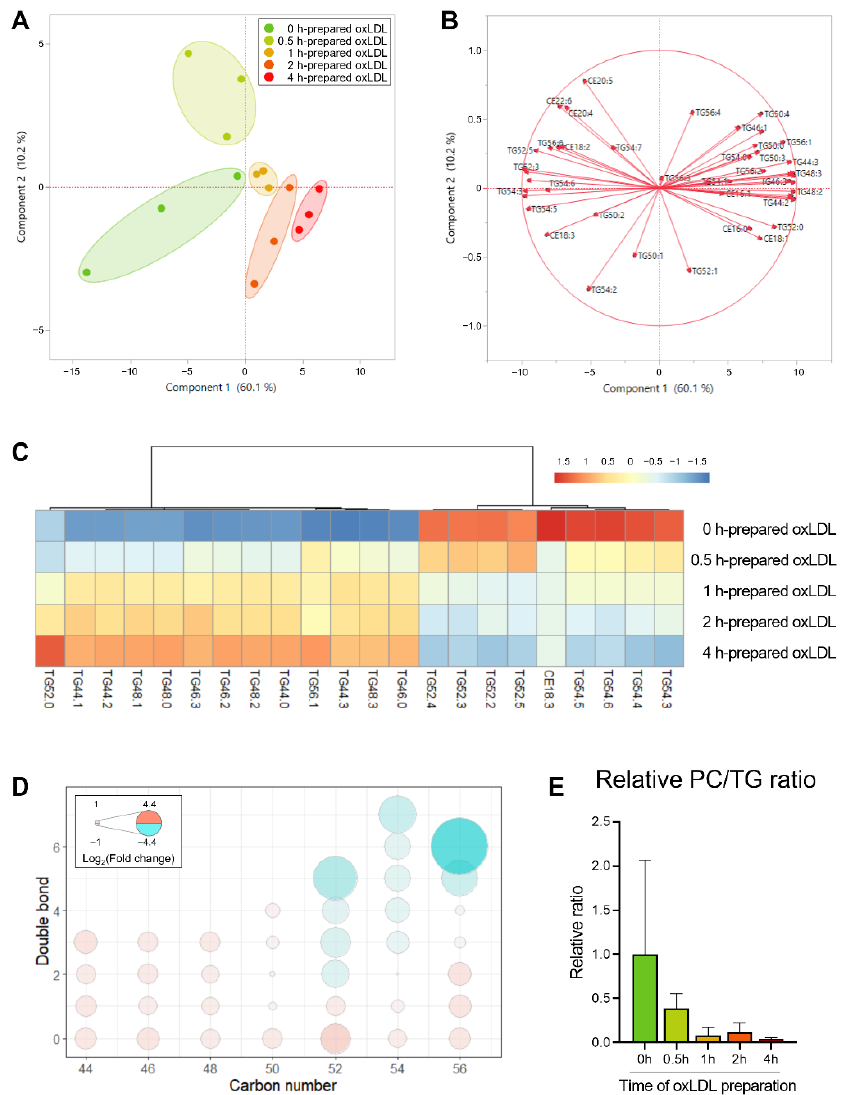
Figure 4. Score plot ( A ) and loading plot ( B ) of PCA revealed the distinguished profile of the intact neutral lipids in LDs from oxLDL-supplemented HK-2 cells. ( C ) Heatmap of the most significant varied LD neutral lipid species among different oxLDL-induced cells. ( D ) Bubble plots of LD TG profile changes in the cells supplemented using oxLDL with different preparation times. The color (ranging from red to cyan) and the bubble scales represent the degree of the difference, calculated as log 2 (change fold of 2 − 4 h groups to 0 − 0.5 h groups). ( E ) PC/TG ratio of LDs in different groups.